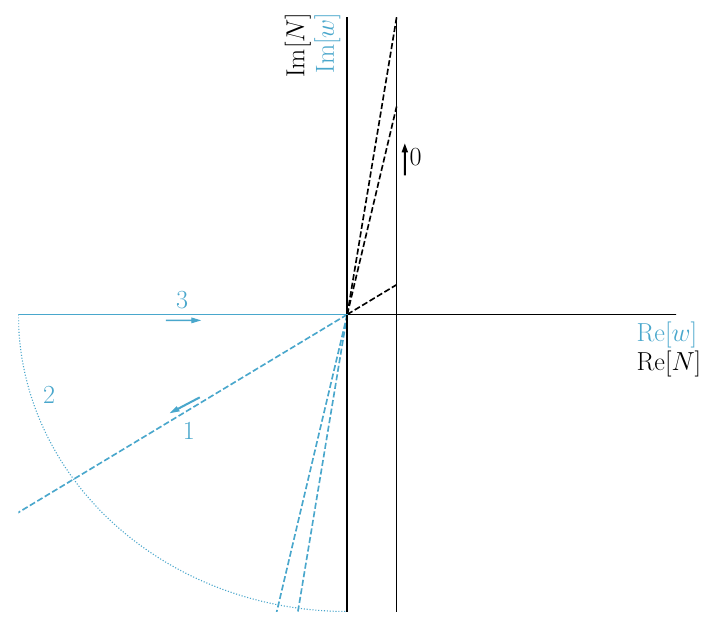
Figure 1 . Schematic representation of the change of variables of eq. (4.14). The solid black line (indicated by 0 ) corresponds to the standard integration path for the inverse Mellin transform, while the dashed blue line ( 1 ) corresponds to the integration path of w after the change of variables. As w is N dependent, we obtain a different integration path for each value of N , as indicated by the other dashed blue lines. We then deform this path to the negative real axis (solid blue line, indicated by 3 ) for all values of N